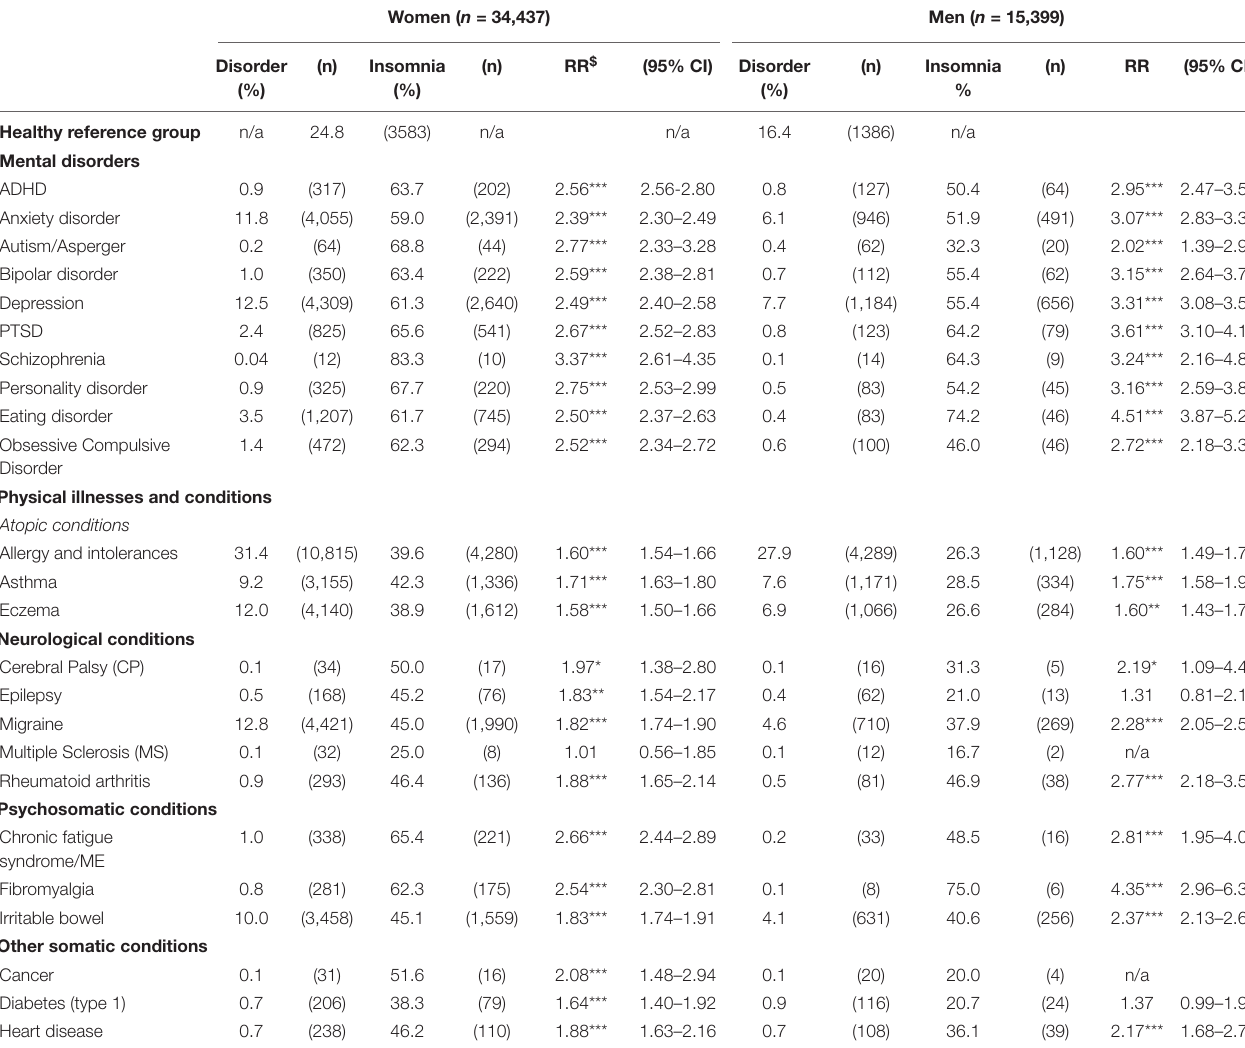
TABLE 1 | Prevalence and risk of DSM-5 insomnia across mental disorders stratified by sex in the SHoT2018 study. Women ( n = 34,437) Men ( n = 15,399)